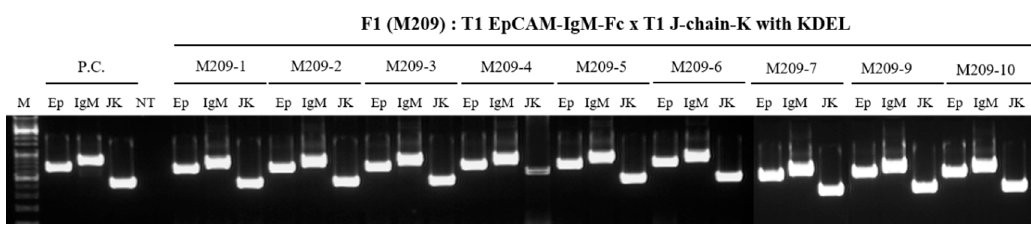
Figure 7. A polymerase chain reaction (PCR) analysis to confirm the transgenes encoding EpCAM–